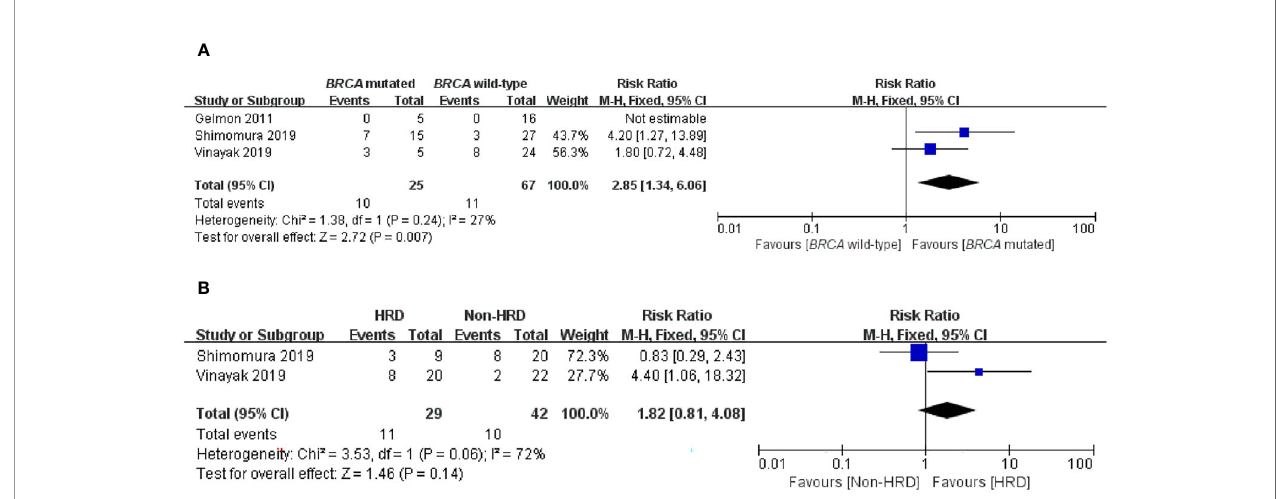
FIGURE 4 | Forest plots of pooled analyses for the effect of PARP inhibitors on ORR in (A) BRCA -mutated vs . BRCA wild-type patients and (B) HRD vs . non-HRD patients.